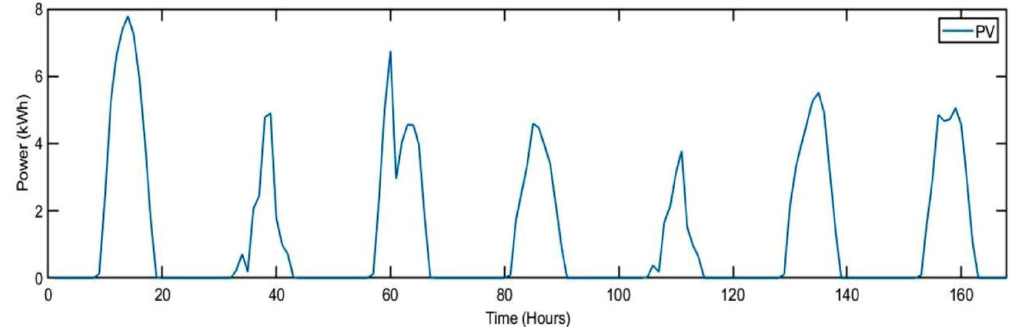
Figure 13. The measured energy flow from the PV panel (6.24 kWp) [46].